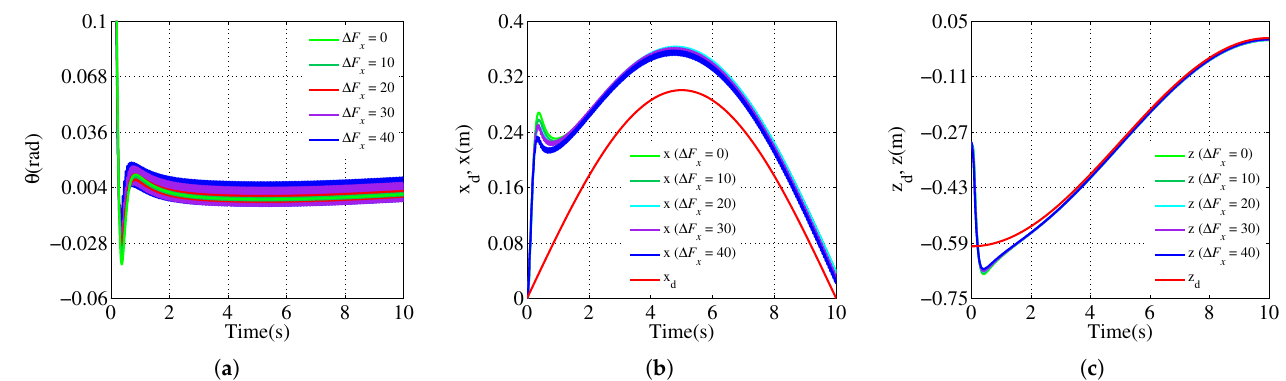
Figure 12. The simulation tests when ∆ F x = 0,10,20,30, and 40. ( a ) The θ ; ( b ) the x d and x ; and ( c ) the z d and z .